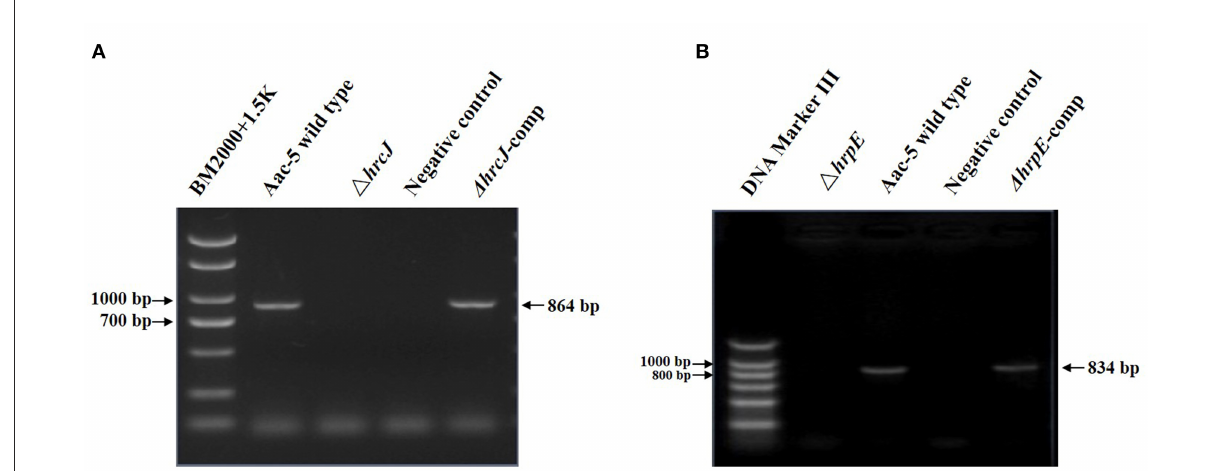
FIGURE1 PCR results for confirmation of the hrcJ (A) and hrpE (B) mutants and complementation strains. (A) An 864-bp band of hrcJ gene was present in the lane of Aac-5 wild type and 1 hrcJ -comp, while was absent in the lane of 1 hrcJ and negative control (ddH 2 O as template). (B) An 834-bp band of hrpE gene was present in the lane of Aac-5 wild type and 1 hrpE -comp, while was absent in the lane of 1 hrpE and negative control.